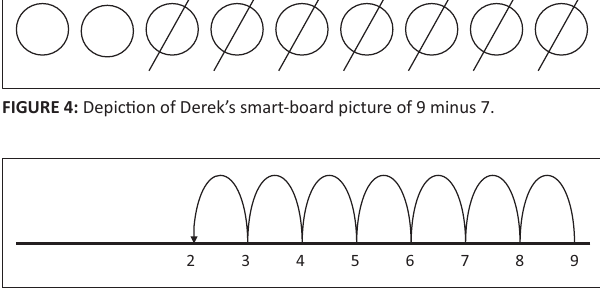
FIGURE 5: Depiction of Lungile’s smart-board empty number line 9 minus